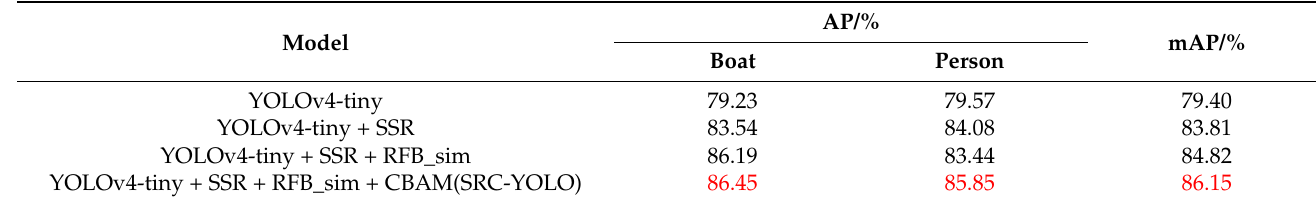
Table 4. The mAP results of ablation